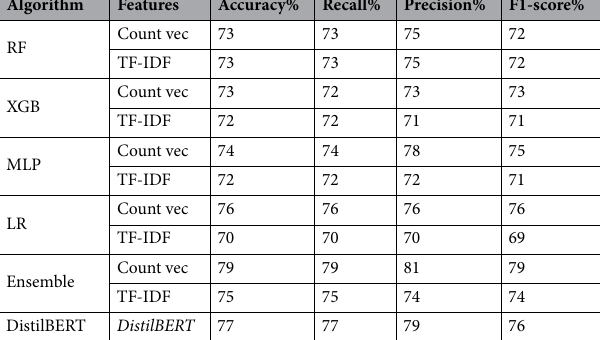
Table 3. All Feature Extraction and algorithm Results for Article1 Dataset with 20 Authors.